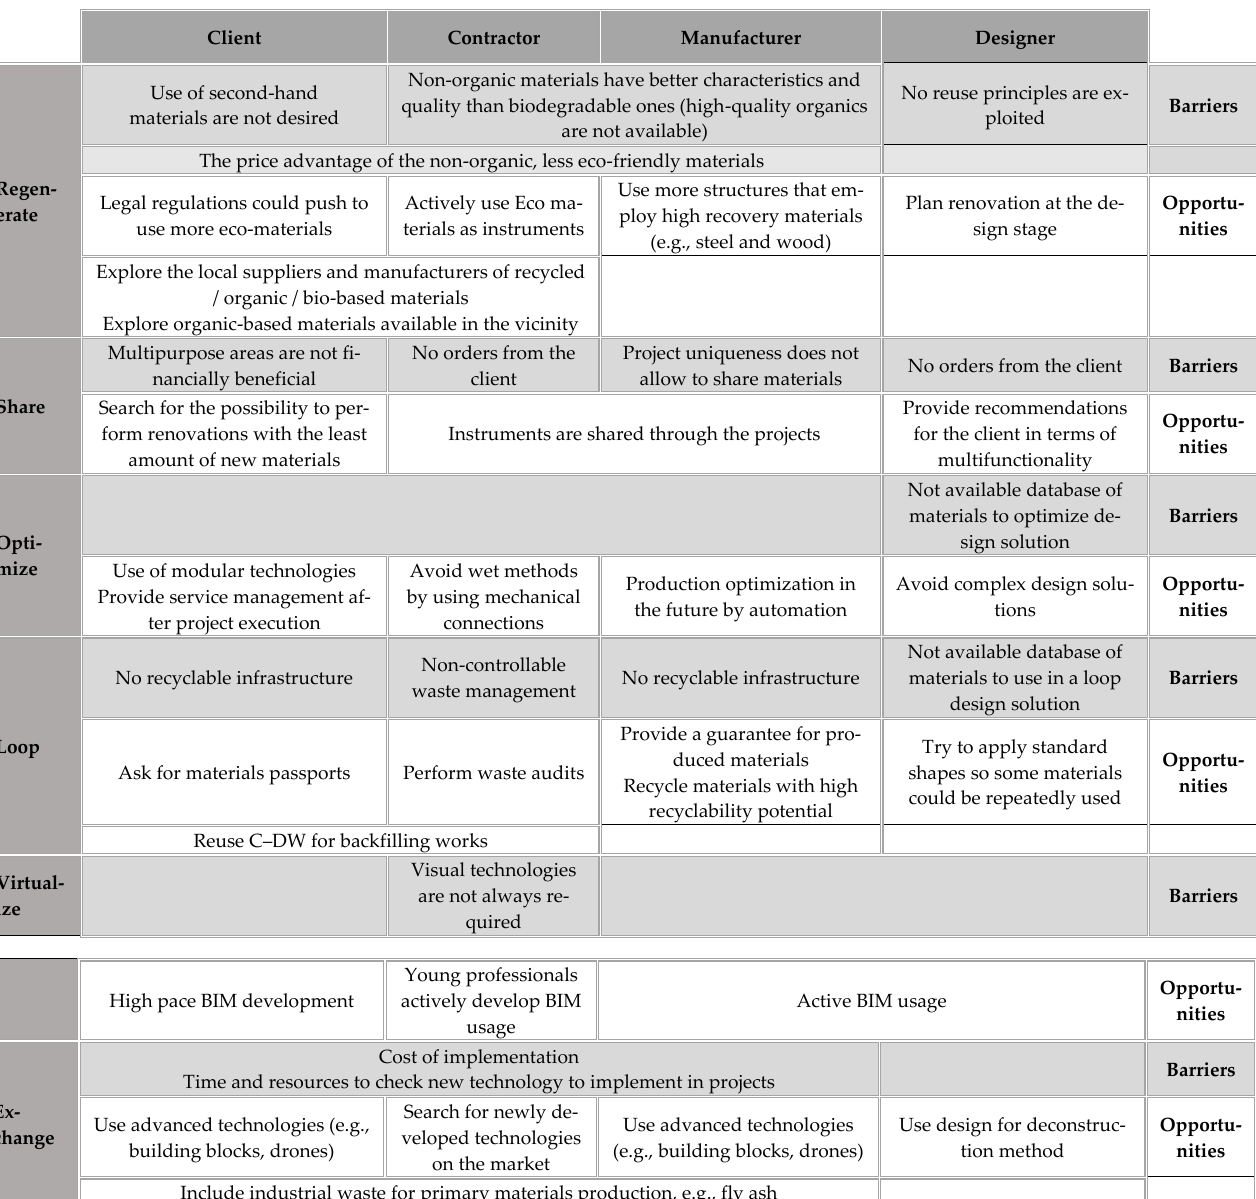
Figure 2. Stakeholder barriers and opportunities analysis in the ReSOLVE framework.